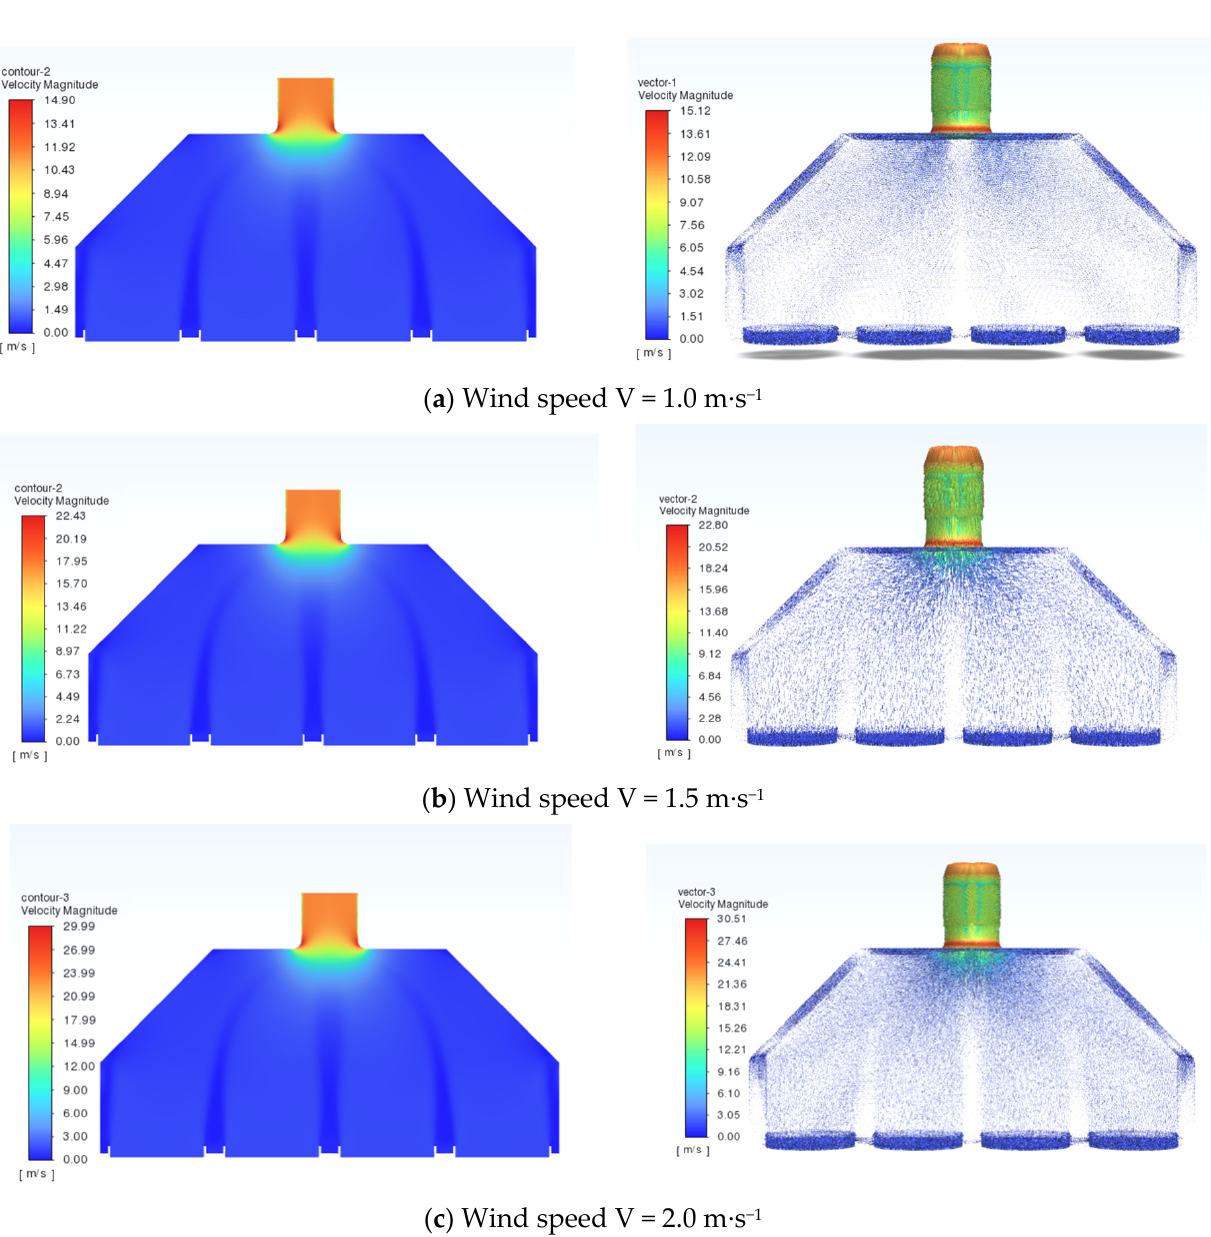
Figure 8. Velocity nephogram and velocity vector diagram under di ff erent wind speeds.